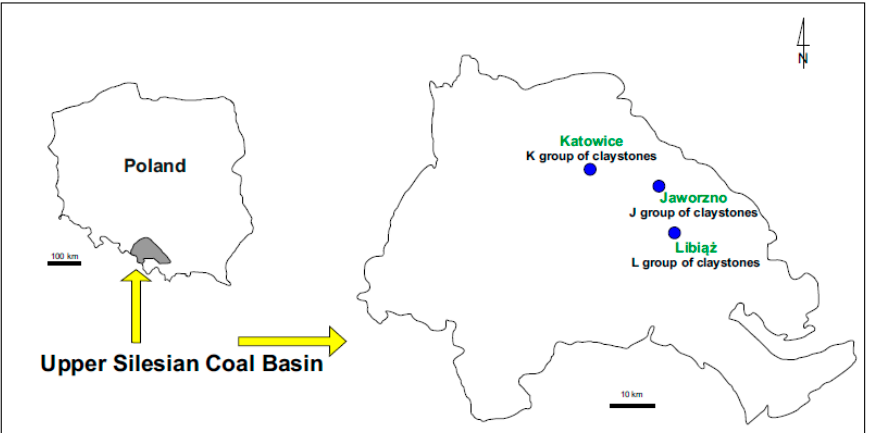
Figure 1. Schematic map of the Upper Silesian Coal Basin. The places from which samples were taken are marked.